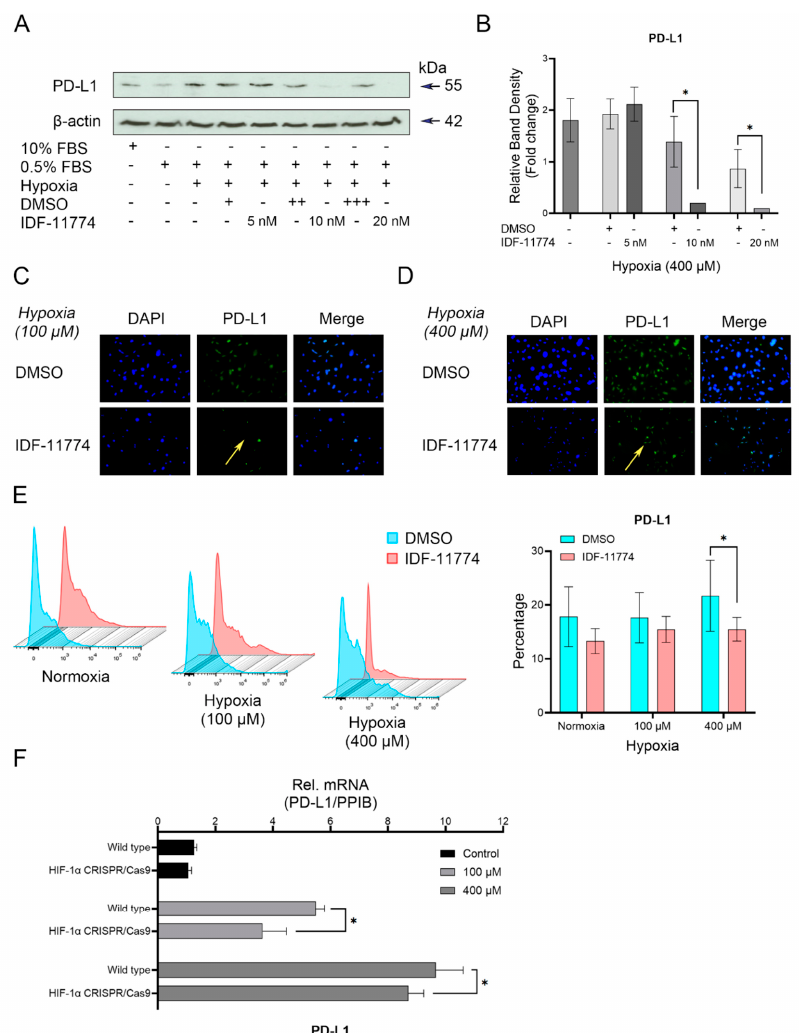
Figure 4. Hypoxia-correlated PD-L1 expression is dependently with HIF-1 α signaling in OCCM-30 cells. ( A , B ) Western blot analysis of PD-L1 protein levels under hypoxia in response to IDF-11774 (20 uM). Graphs show the fold change of PD-L1 expression as compared to their corresponding control group. Internal β -actin levels serve as loading control. ( C , D ) Representative IF staining showing the expression of PD-L1 in hypoxia-stimulated OCCM-30 cells with treatment of IDF-11774 (20 uM) for 24 h. Yellow arrows indicated the PD-L1 positive cells. ( E ) Representative plots of the analysis of the expression level of PD-L1 in OCCM-30 by flow cytometry. The graphic shows the values of PD-L1 positive cells normalized to total cells. Data are expressed as percentage. Each group was performed in triplicate. ( F ) Knockdown of HIF-1 α gene expression by CRISPR/Cas9 decreased the hypoxia-induced PD-L1 gene expression in OCCM-30 cells. The blots and photomicrographs represent three independent experiments with SD. Statistically significant differences (indicated by asterisks) are indicated as follows (ns, no significant difference; * p <